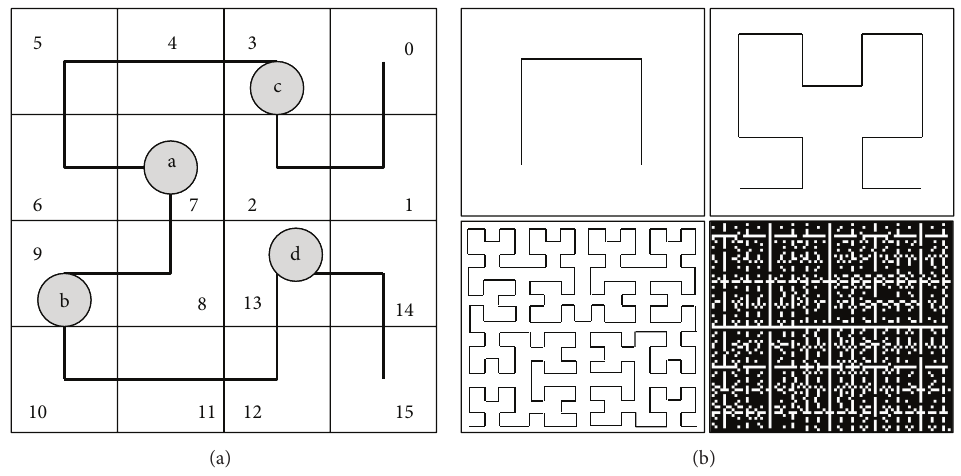
Figure 1: (a) A 𝐻 2 2 pass of the 2D space and (b) Hilbert curves with various